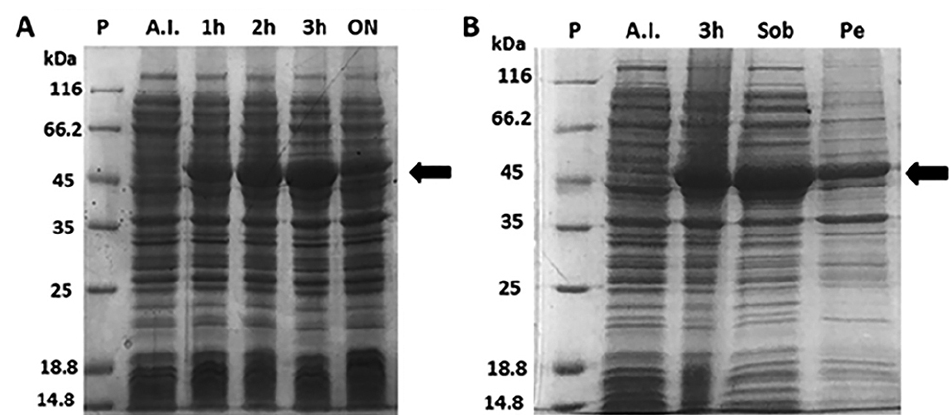
Figure 3. Heterologous expression of recombinant protein Hisx6MBP-AgCecropB and E. coli BL21 (DE3) cell lysis. (A) 12% SDS-PAGE of Hisx6MBP- AgCecropB expression using IPTG (0.5 mM) to induce expression, at 28 °C. P: molecular mass standard; A.I.: aliquot before induction; 1h, 2h, 3h, 4h, ON: aliquots after 1, 2, 3, 4 and 16 hours after induction. Arrow points to Hisx6MBP-AgCecropB expected molecular mass (